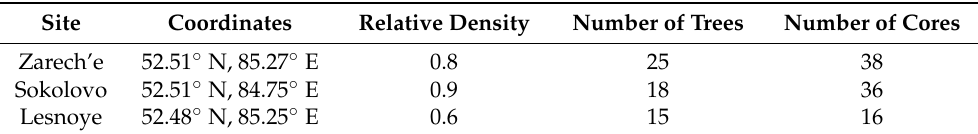
Table 1. Characteristics of the study sites. Relative density is ratio of real basal area of tree stems to reference one (a unit fraction). Site Coordinates Relative Density Number of Trees Number of Cores Zarech’e 52.51 ◦ N, 85.27 ◦ E 0.8 25 38 Sokolovo 52.51 ◦ N, 84.75 ◦ E 0.9 18 36 Lesnoye 52.48 ◦ N, 85.25 ◦ E 0.6 15